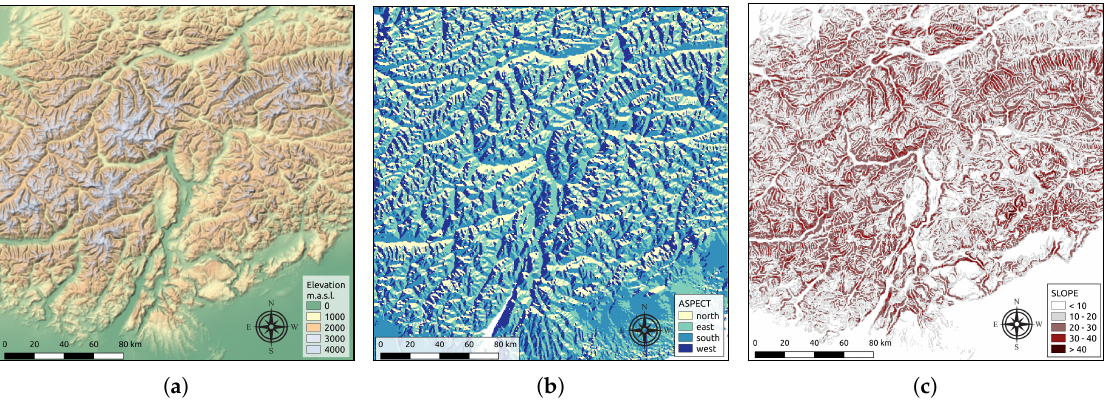
Figure 8. Overview of the three orographic features used for the ESG model: ( a ) elevation map resampled over the radar grid at 500 500 m resolution; ( b ) orientation derived from the elevation × map, where the colors show the nearest cardinal direction N (0), E (90), S (180), and W (270); and ( c ) percentage slope derived from the elevation.